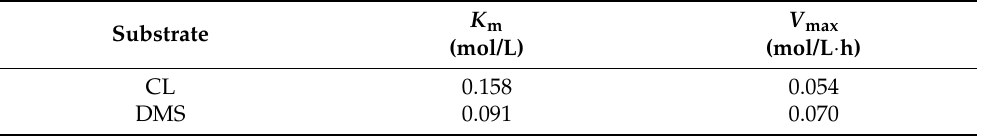
Figure 3. 1 H NMR spectra of the reaction of BnOH with CL ( a ) and DMS ( b ) in the presence of CALB at 70 ◦ C in deuterated toluene. CL and DMS substrate concentration kept at 5 mg/mL. Table 1. Michaelis–Menten constants 1 of CALB enzyme reaction of CL and DMS with BnOH at 70 ◦ C in toluene solvent.